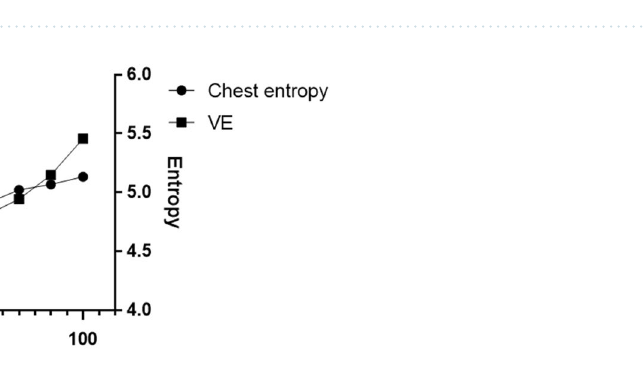
Figure 3. Mean temperature and entropy of the ROIs during the exercise test. The x-axis represents the percentage of the exercise test time. The y- axis represents ( A ) the forehead temperature, ( B ) the chest temperature, ( C ) the abdomen temperature, ( D ) the forehead entropy, ( E ) the chest entropy, and ( F ) the abdomen entropy.